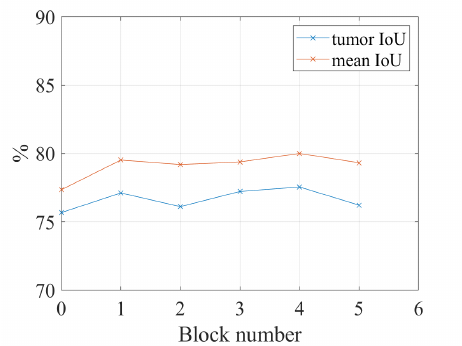
Figure 7. The relation between the number of fuzzy blocks and the segmentation performance. The fuzzy blocks are applied to the convolutional blocks individually. Block number = 1: the fuzzy blocks are applied to the first convolutional block; block number = 2: the fuzzy blocks are applied to the second convolutional block; block number = 3: the fuzzy blocks are applied to the third convolutional block; block number = 4: the fuzzy blocks are applied to the fourth convolutional block; block number = 5: the fuzzy blocks are applied to the fifth convolutional block.